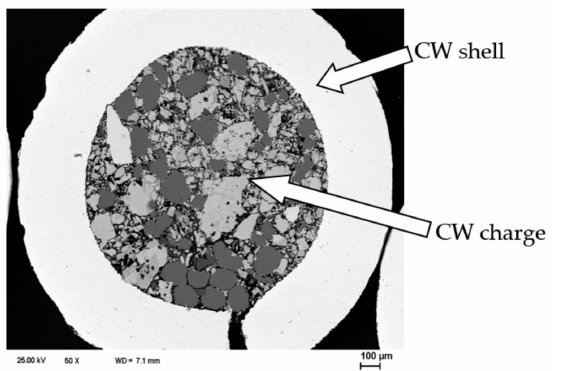
Figure 1. Cross section of cored